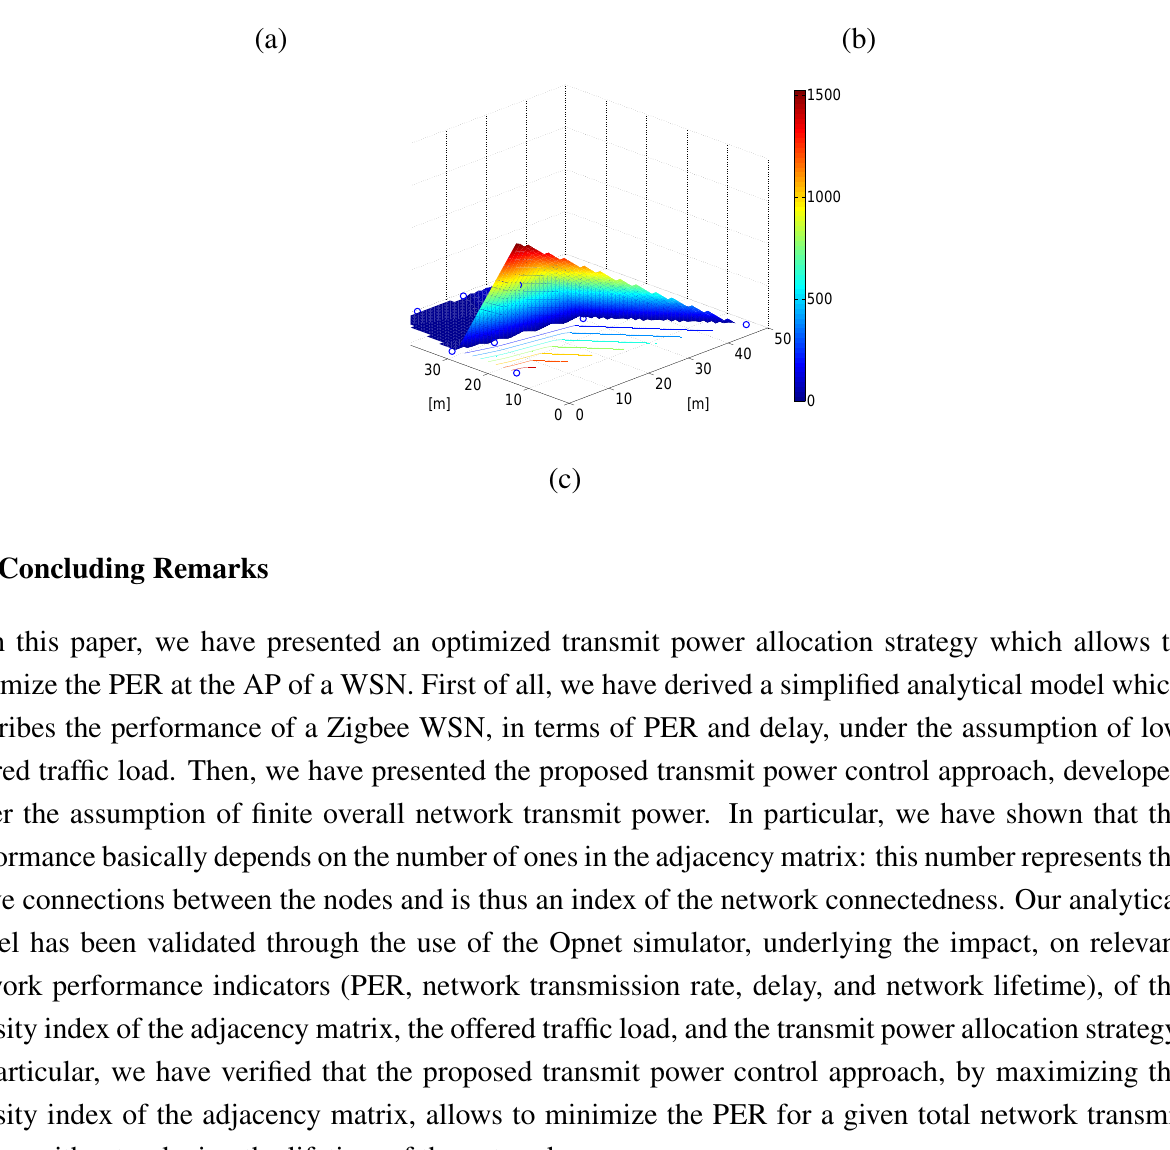
Figure 19. Residual energy with RSSI-based power allocation strategy of [11], in a scenario with N = 10 nodes after (a) 0 days, (b) 45 days, and (c) 90 days.